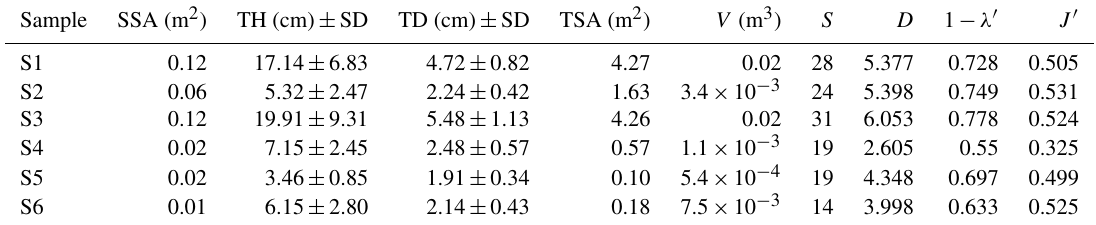
Table 2. Univariate measures of macrofaunal community structure associated with Ridgeia piscesae tubeworm bushes on the Grotto edi- fice: sample surface area (SSA), tube height (TH), tube diameter (TD), tubeworm surface area (TSA), volume ( V ), species richness ( S ), exponential of Shannon entropy ( D ), Simpson’s diversity index (1 − λ (cid:48) ) and Pielou’s evenness ( J (cid:48) ). Sample SSA (m 2 ) TH (cm) ± SD TD (cm) ±